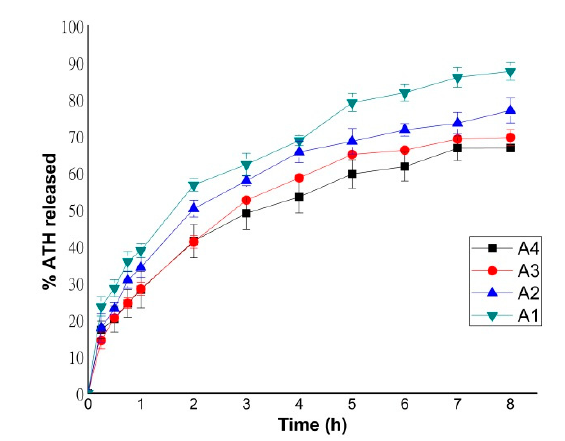
Figure 9. Dissolution profiles of formulations A1–A4.